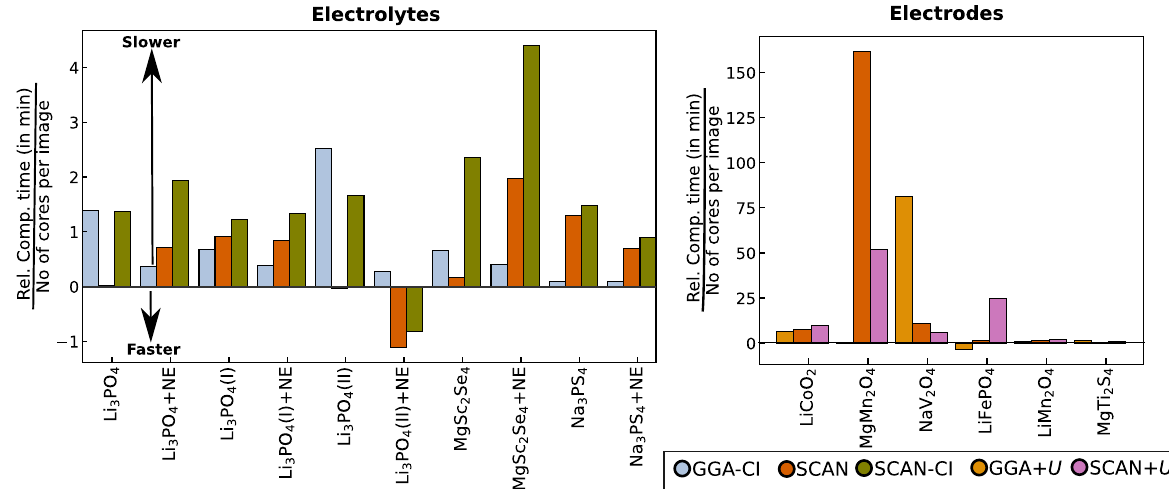
Fig. 7 Relative computing time, in units of minutes taken per number of cores used per NEB image for all the E m calculations performed in this work. NE and CI represent addition of NELECT and CI, respectively. Li 3 PO 4 (I) and Li 3 PO 4 (II) represent 2(c) → 3(d) and 1(d) → 2(c) hop